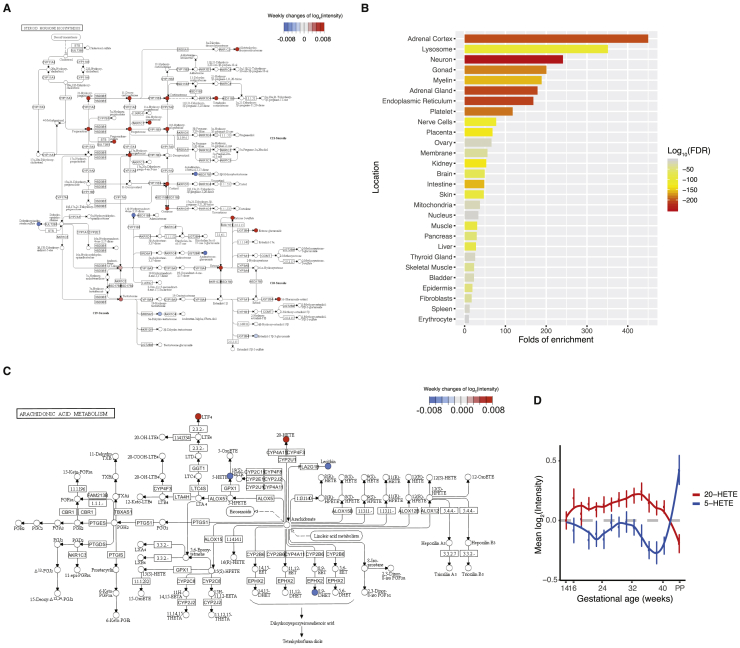
Pregnancy-Related Metabolic Pathways and Metabolite Origin Analysis, Related to Figure 3(A) Steroid hormone biosynthesis pathway, with metabolite increases (in red) or decreases (in blue) over the course of gestation.(B) Numerous metabolites in plasma that were altered during pregnancy can be traced back to organs by metabolite set enrichment analysis (MSEA).(C) Arachidonic acid metabolism pathway, with metabolite increases (in red) or decreases (in blue) over the course of gestation.(D) The average levels of the 20-HETE and 5-HETE changes against the gestational progression. The intensities were normalized to the baseline, which was defined by averaging all samples before 14 weeks. The standard errors, derived from 30 subjects, are shown. The gestational ages were adjusted by scaling delivery events to 40 weeks. PP, postpartum.